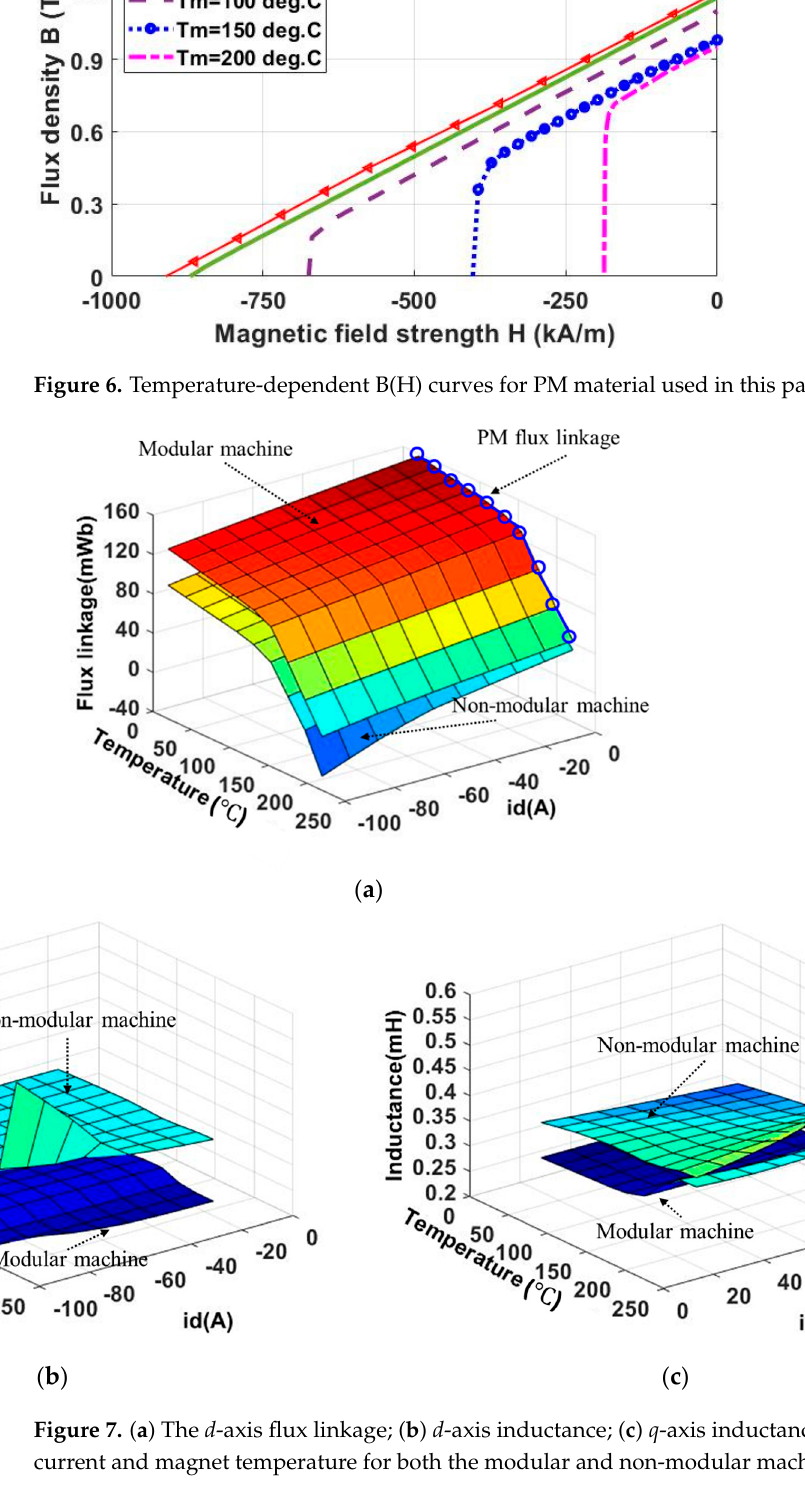
Figure 7. ( a ) The d -axis flux linkage; ( b ) d -axis inductance; ( c ) q -axis inductance vs. d - or q -axis axis current and magnet temperature for both the modular and non-modular machines.